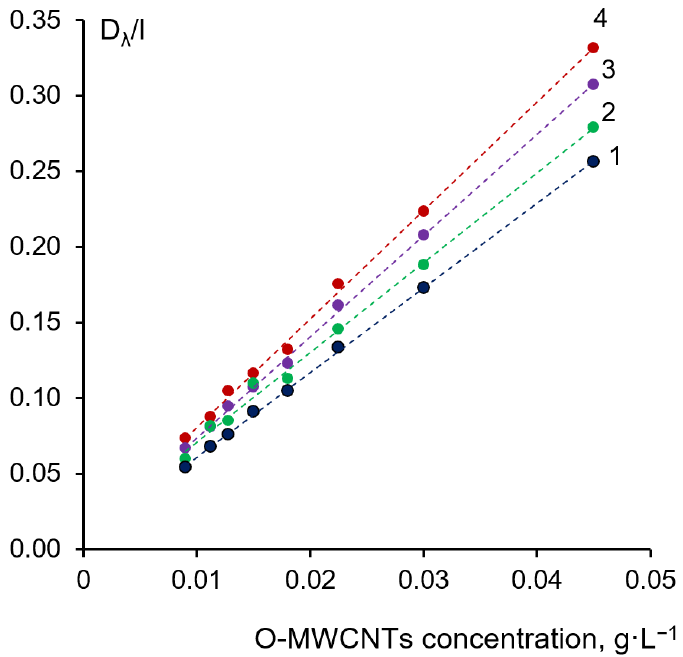
Figure 2. Correlation between the ratio of the absorbance to the optical path (D λ /l) and O-MWCNTs concentration in the dispersion at different wavelengths, nm: 1—700; 2—600; 3—500; 4—450.